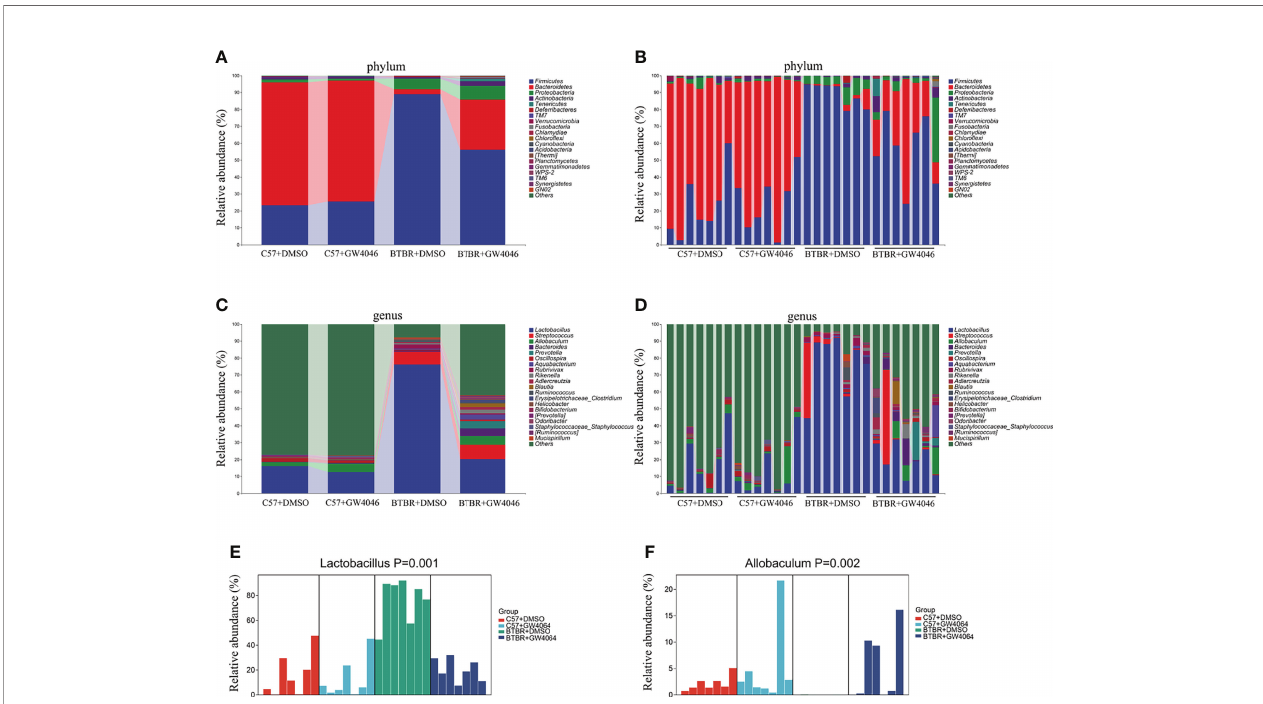
FIGURE 7 | GW4064 treatment changed the autism-associated microbiota dysbiosis. (A, B) Bar plots of the phylum taxonomic levels among four groups (only the top 20 phylum bacteria are shown). Relative abundance is plotted for each sample (B) and the average of each group (A). (C, D) Bar plots of the genus taxonomic levels among four groups (only the top 20 genus bacteria are shown). Relative abundance is plotted for each sample (D) and the average of each group (C). (E) The relative abundance of the genus Lactobacillus in each sample was displayed by bar plots. (F) The relative abundance of genus Allobaculum in each sample was displayed by bar plots. n =